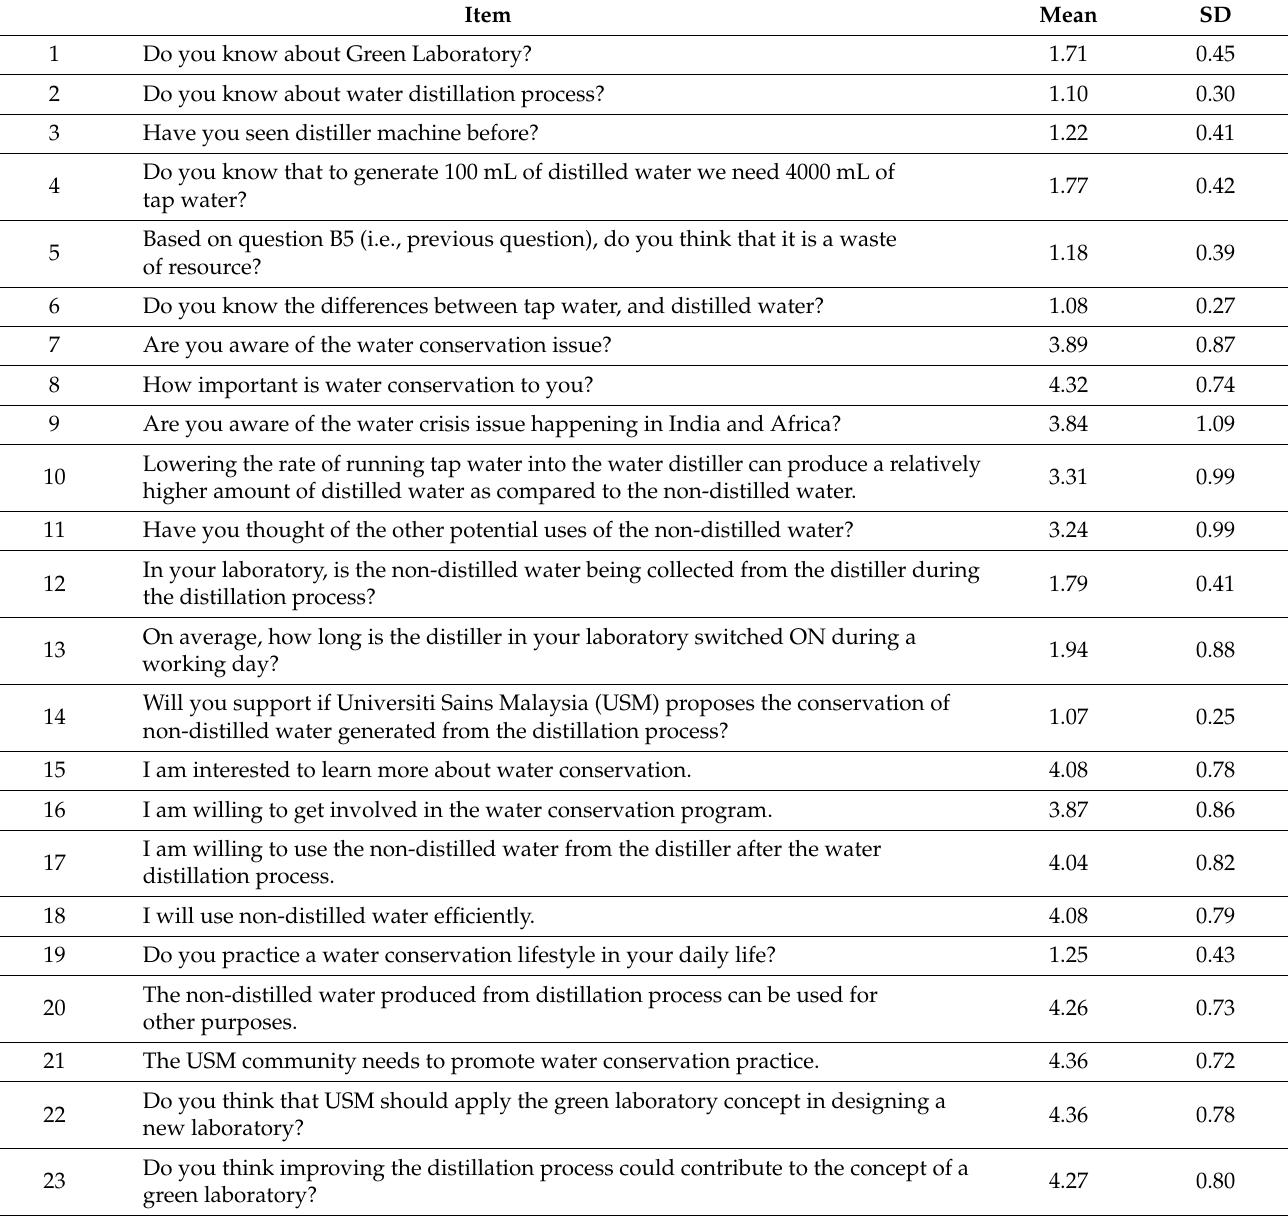
Table 2. Mean and standard deviation (SD) of item